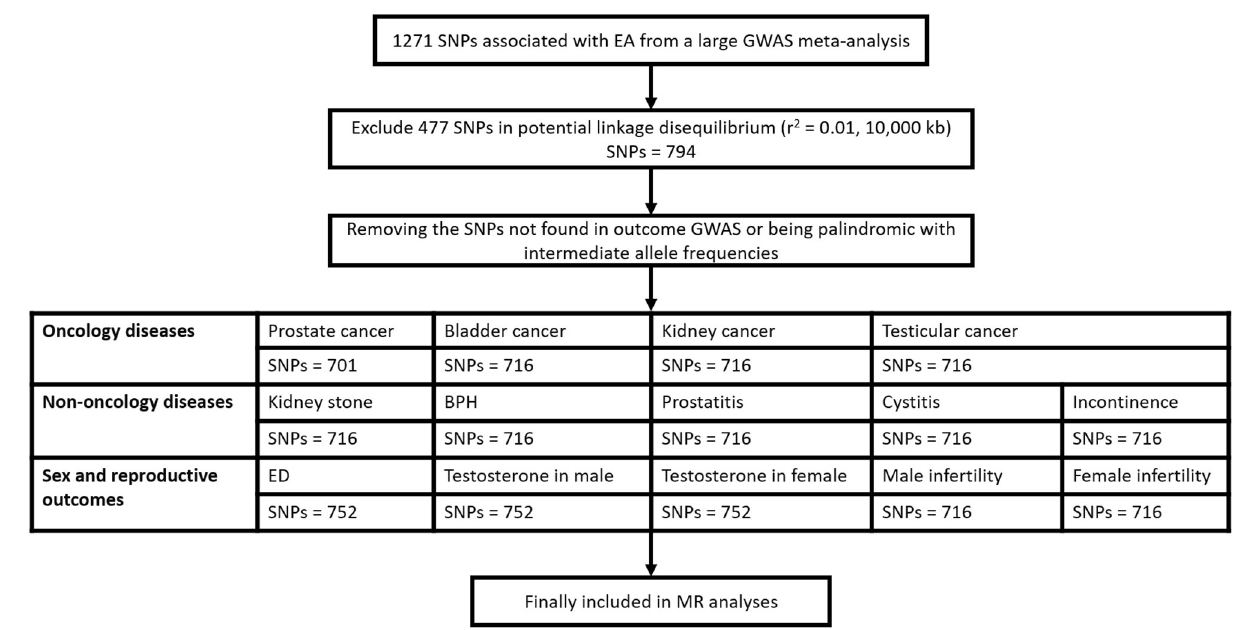
Frontiers in Public Health |